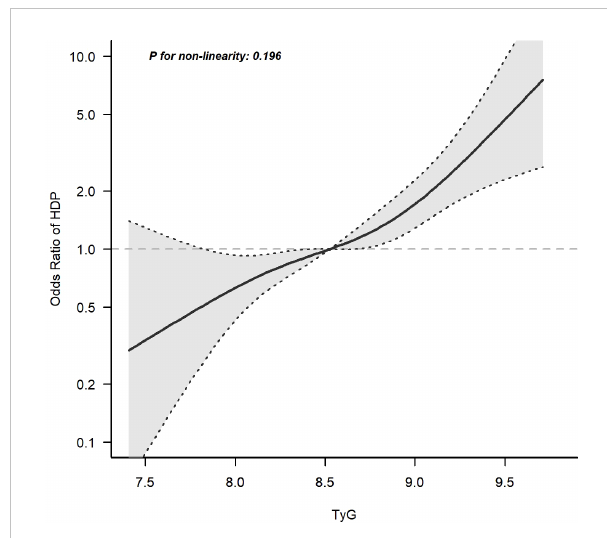
FIGURE 4 Continuous association of the TyG index at the fi rst visit with the incidence of HDP. Adjusted for age, pre-pregnancy BMI, family history of hypertension and parity. The risk of developing HDP increased when the TyG index was greater than